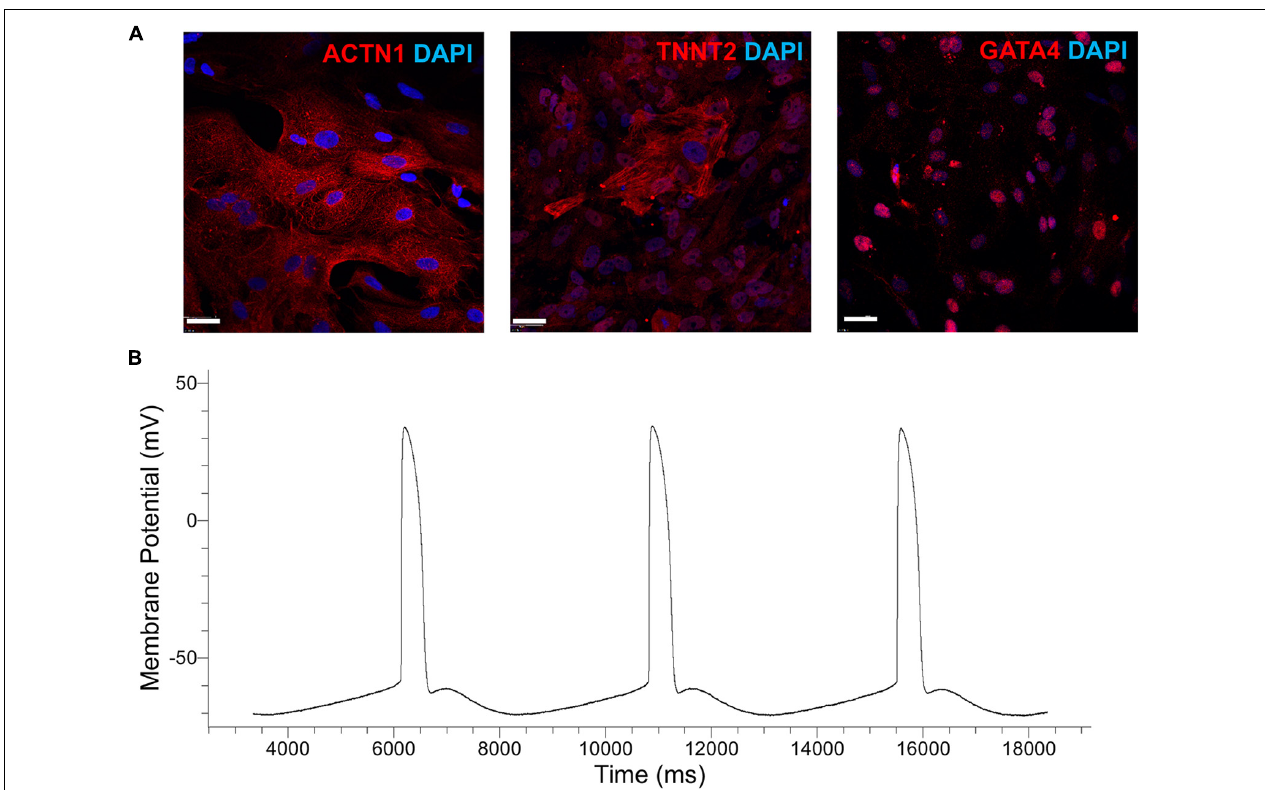
FIGURE 5 | (A) Immunostaining of cells generated by the cardiogenic differentiation of hPSCs in spinner flasks. Representative micrographs are shown of ACTN1 (B12-3), TNNT2 (H9), and GATA4 (IMR90-4). DAPI staining of nuclear DNA is also shown. Bars: 50 µ m. (B) Patch-clamp analysis of H9-derived CMs. A representative action-potential graph is shown.